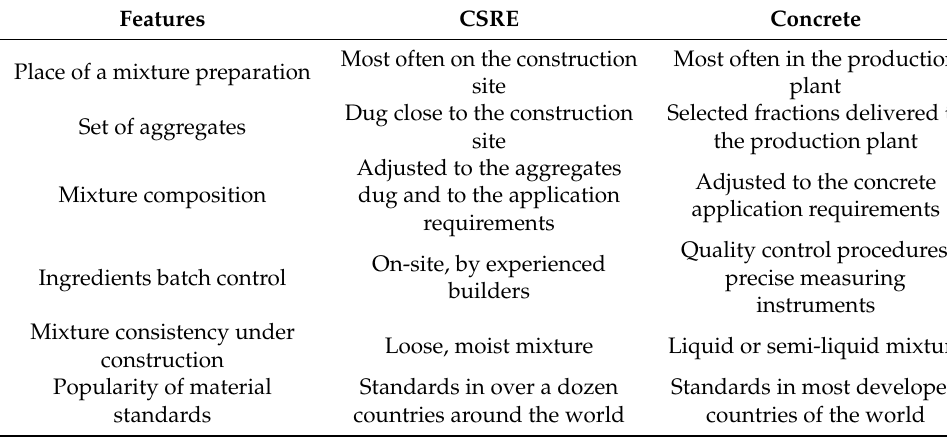
Table 6. Main differences between CSRE and concrete.